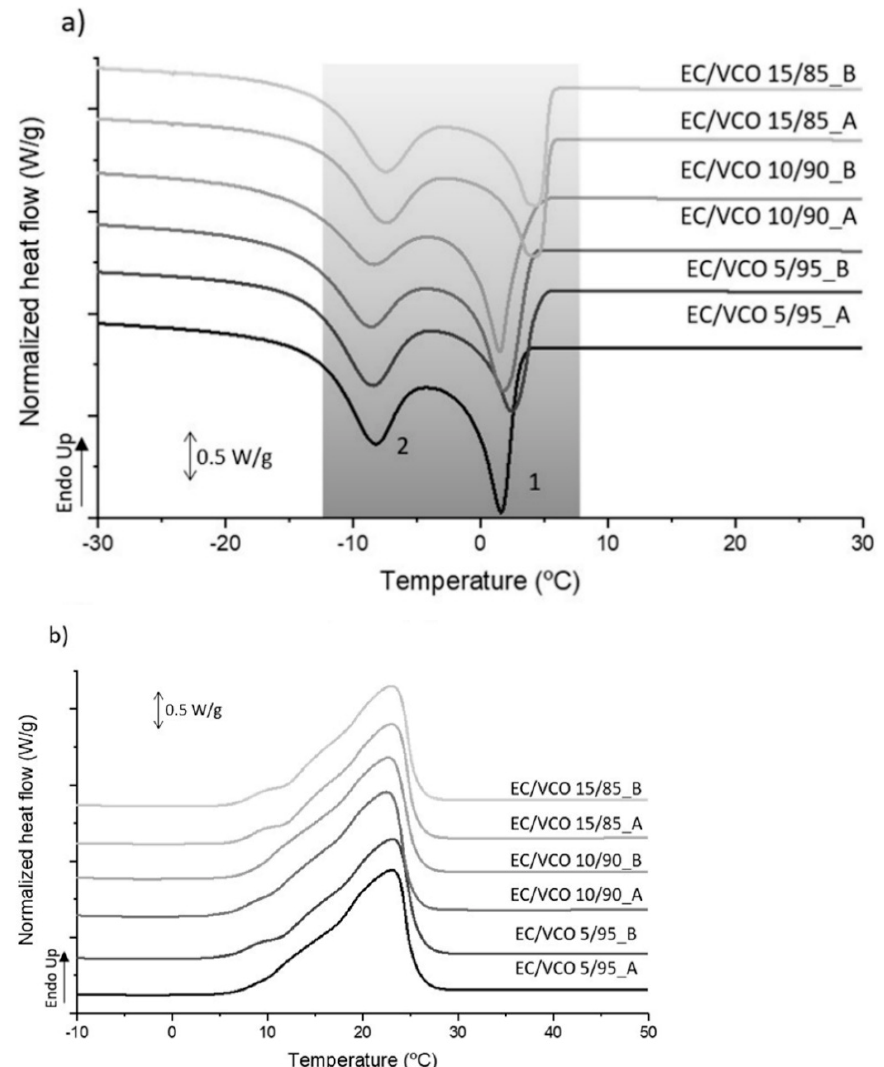
Figure 6. DSC thermograms obtained for EC/VCO oleogels using 10 °C/min − 1 ; ( a ) crystallization process and ( b ) melting process.